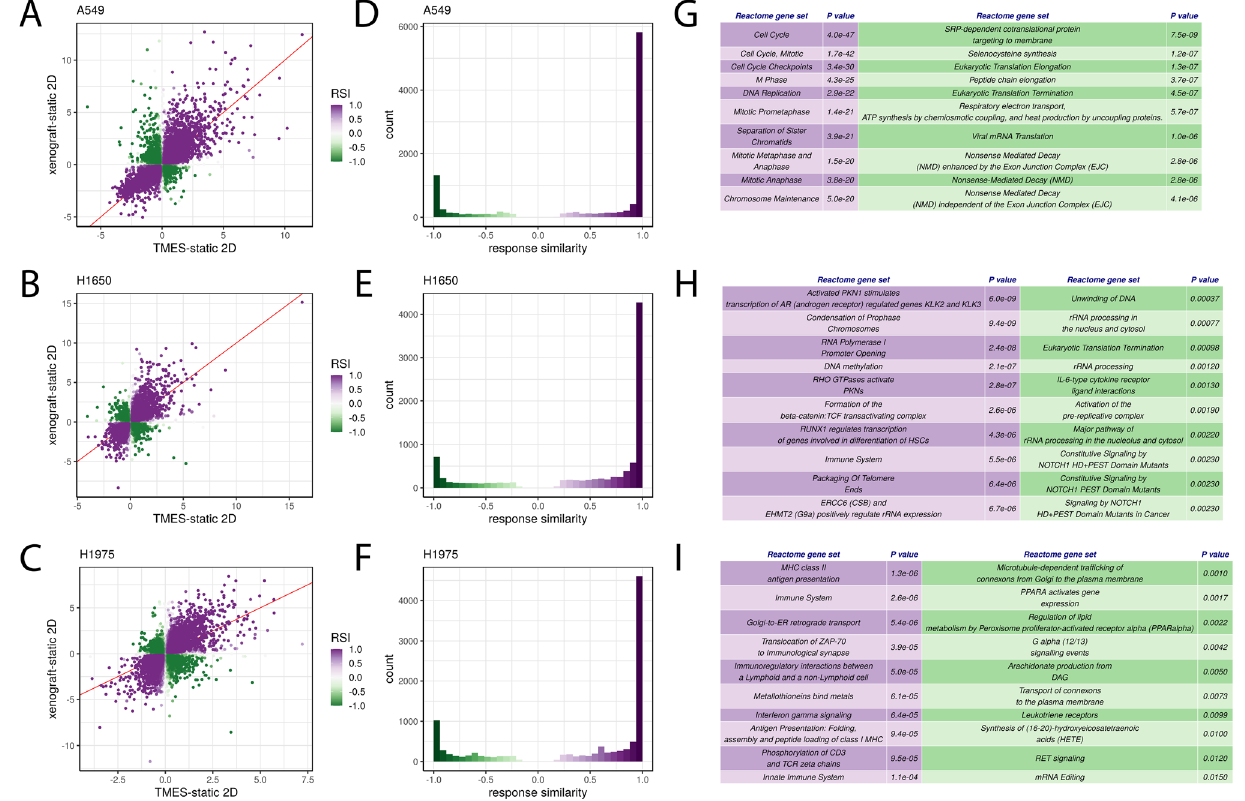
Figure 2. Response Similarity Analysis of NSCLC cell lines from the TMES and xenografts relative to 2D static cultures. ( A – C ) Xenograft vs TMES scatterplots log2 fold changes relative to static cell culture. Points are colored by their response similarity (RSI), where darker, more saturated colors indicate transcripts that show greater evidence for joint differential expression on both axes. Purple indicates transcripts that are concordantly regulated between the two conditions, whereas green indicates discordance. ( D – F ) Histograms of RSI values in ( A – C ). n = 6 for TMES, 2D static samples and xenografts. ( G – I ) Top ten concordantly (purple) and discordantly (green) regulated Reactome